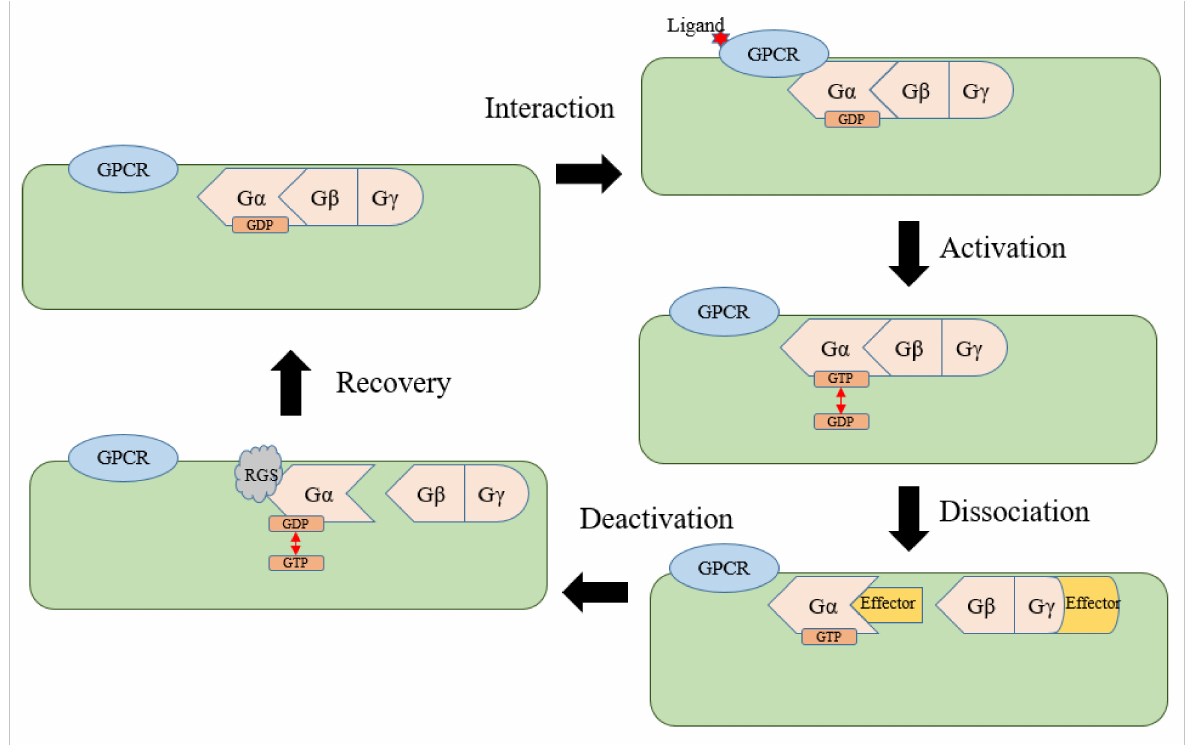
Figure 3. A proposed model of G-protein signaling cycle in